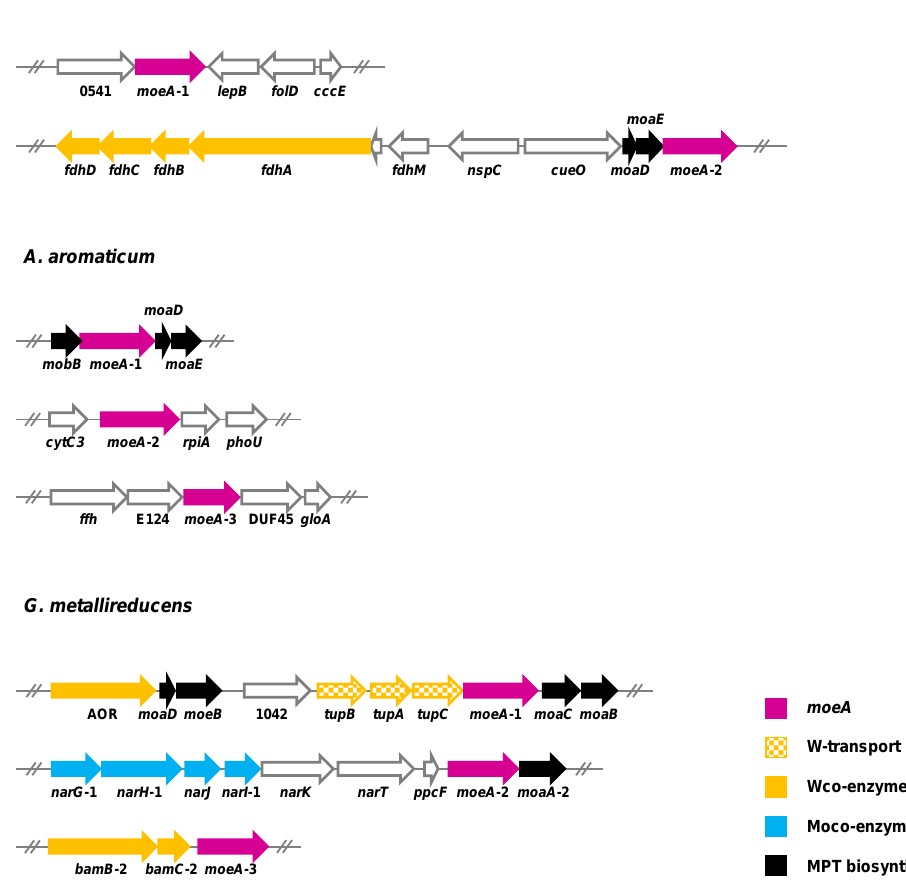
Figure 9. Genomic location of moeA paralogues in bacteria that produce Wco- and Moco-containing enzymes simultaneously.